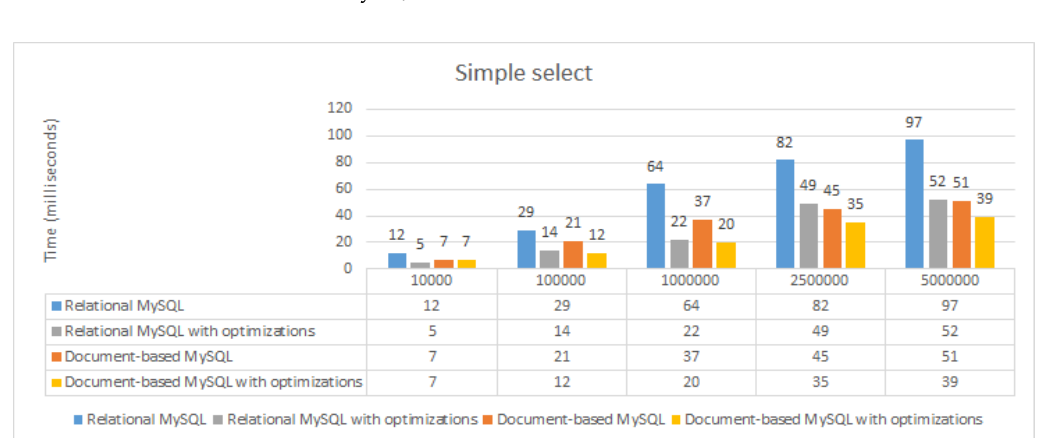
Figure 8. Performance time (ms) for the simple select operation.